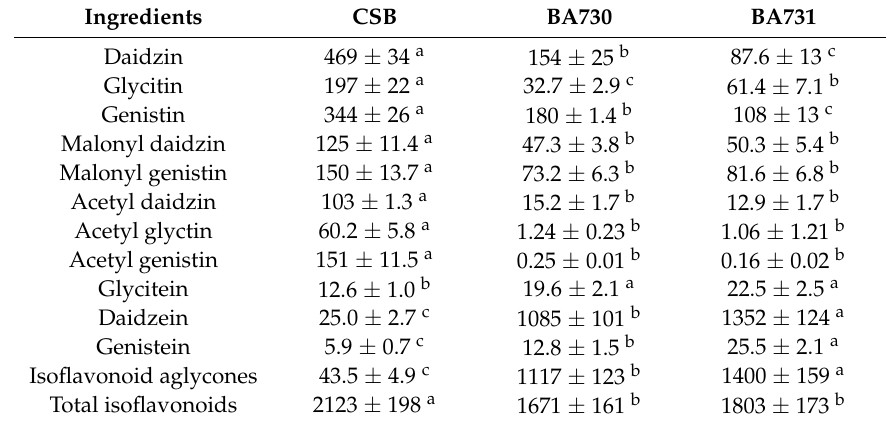
Table 2. Isoflavonoid contents in 70% ethanol extract of cooked soybean and chungkookjang made with B. amyloliquefaciens. (unit: µ g/g dry soybean or chungkookjang).